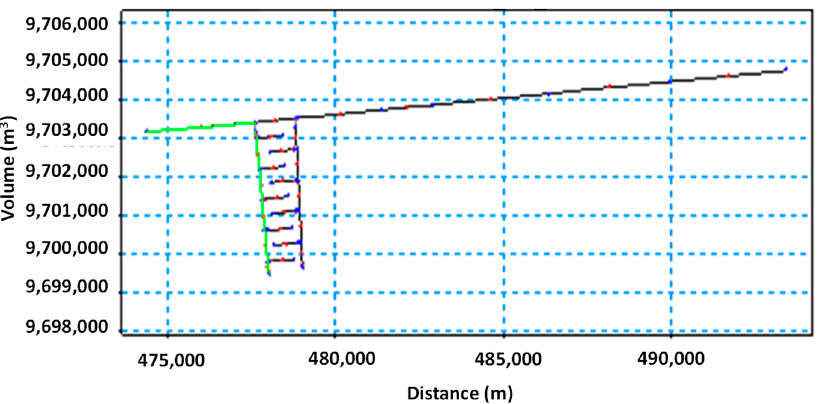
Figure 6. Schematic diagram of channel models for sediment movement in RC without sluicegate of the scenario I (OM 25%).